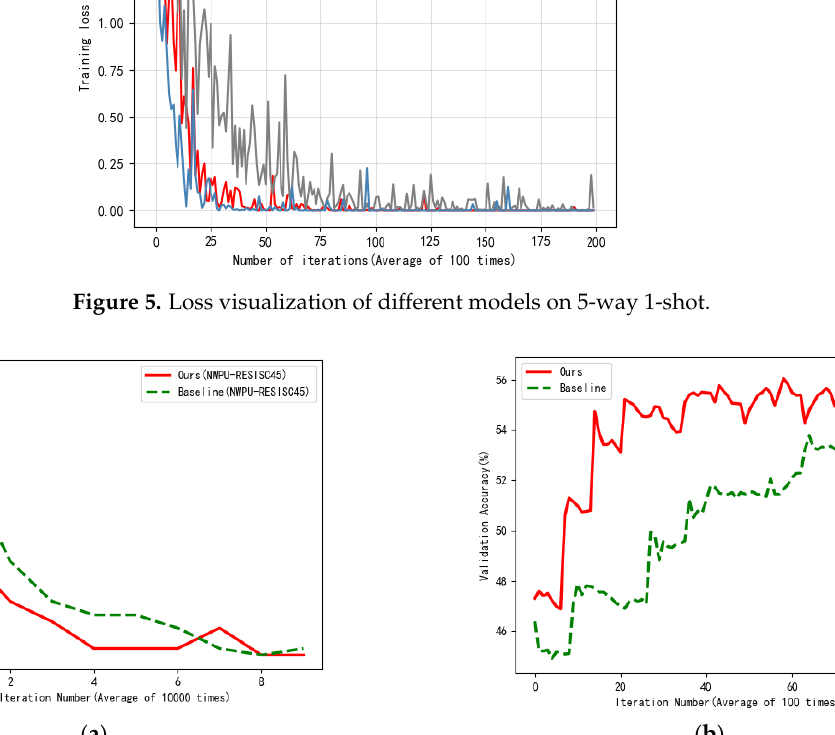
( b ) Figure 7. Ablation experiment of three datasets. ( a ) is the ablation experiment on 5 ‐ way 1 ‐ shot, and ( b ) is the ablation experiment on 5 ‐ way 5 ‐ shot.